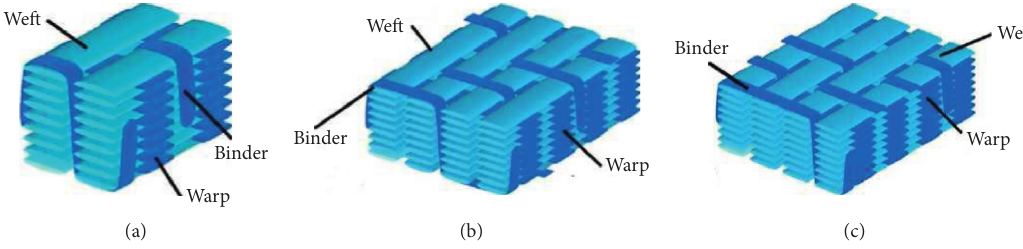
Figure 6: Examples of possible weave binding patterns for ORT: plain (a), twill (b) and satin (c)